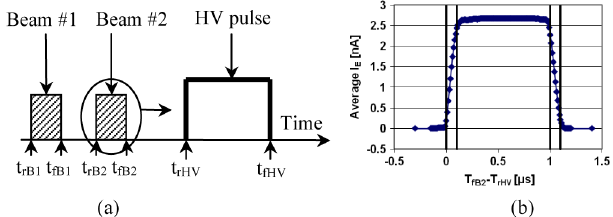
FIG. 4. (a) Pulsing diagram of the test, T B1 ¼ T B2 ¼ 0 : 1 (cid:1) s , ¼ 1 (cid:1) s , V ¼ 1 kV ; t (cid:2) t ¼ 0 : 9 (cid:1) s ; beam #2 T HV HV rHV rB1 swept across the HV pulse in steps of 10 ns. (b) Average emission current at each step. First vertical line: t fB2 ¼ t rHV ; second vertical line: t rB2 ¼ t rHV ; third vertical line: t fB2 ¼ t fHV ; fourth vertical line: t rB2 ¼ t fHV . The emission gain at the flattop was 90.